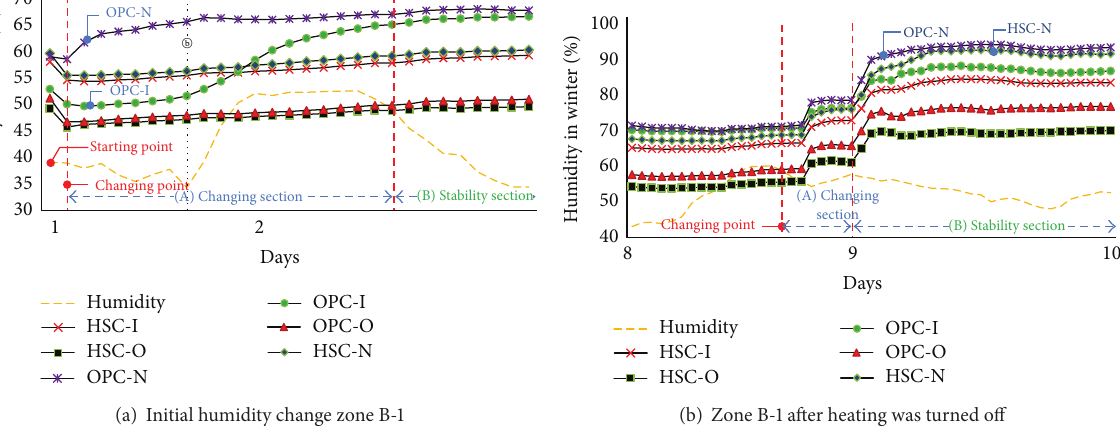
Figure 7: Humidity change zone (B-1 and B-2) in the interior of the specimens in winter.